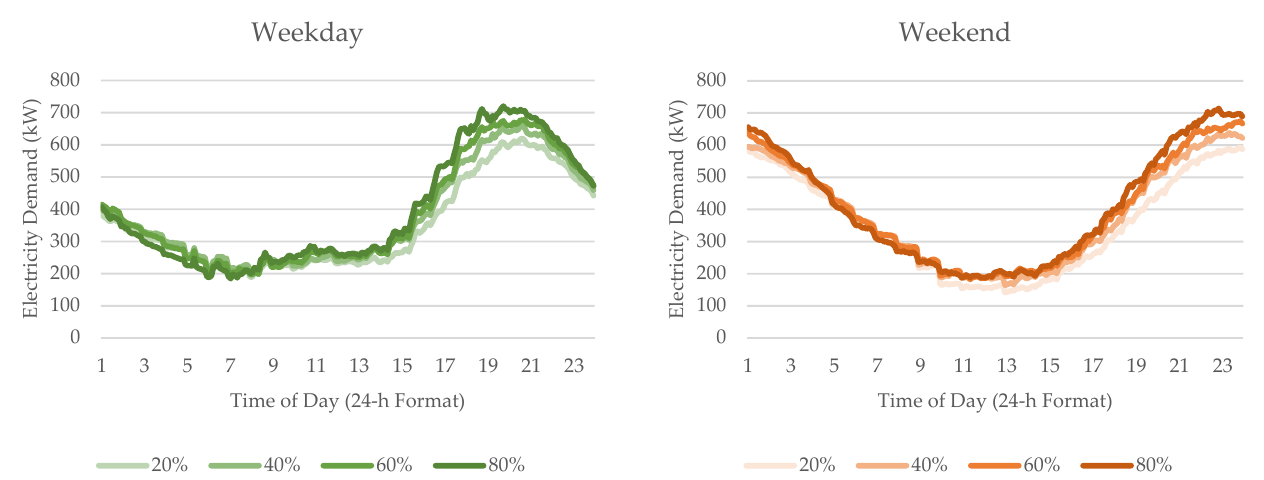
Figure 5. Effect of increasing varying charging thresholds of individuals. Darker curves refer to higher thresholds (i.e., more frequent charging).